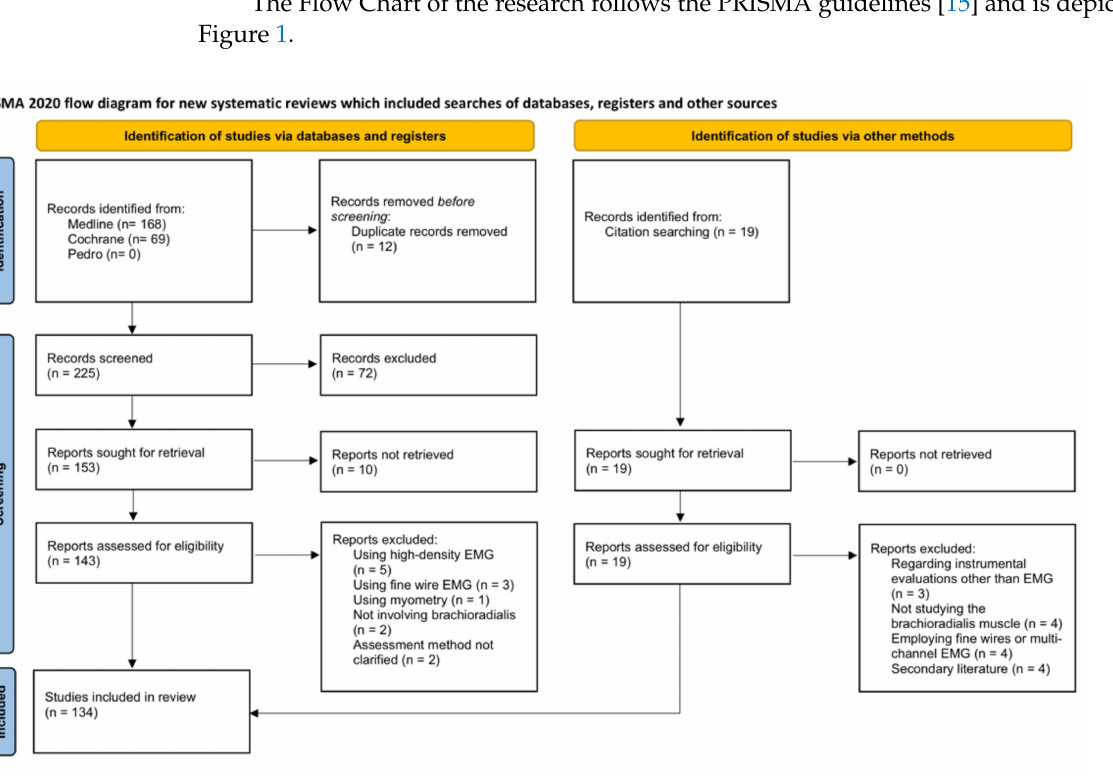
Figure 1. Flow chart of the literature search on surface electromyography of the brachioradialis muscle.